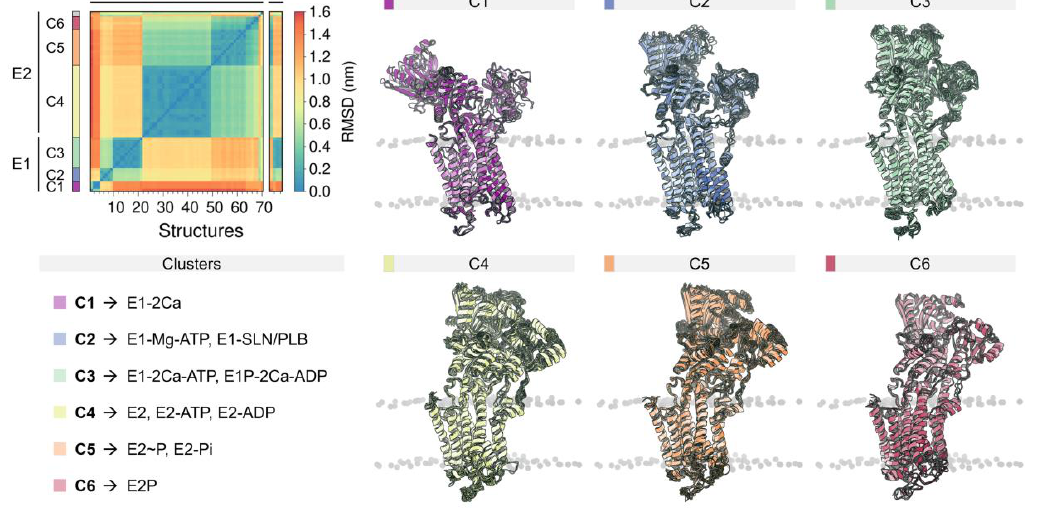
Figure 2. ( A ) Backbone root-mean-square deviation (RMSD) matrix of SERCA1a and